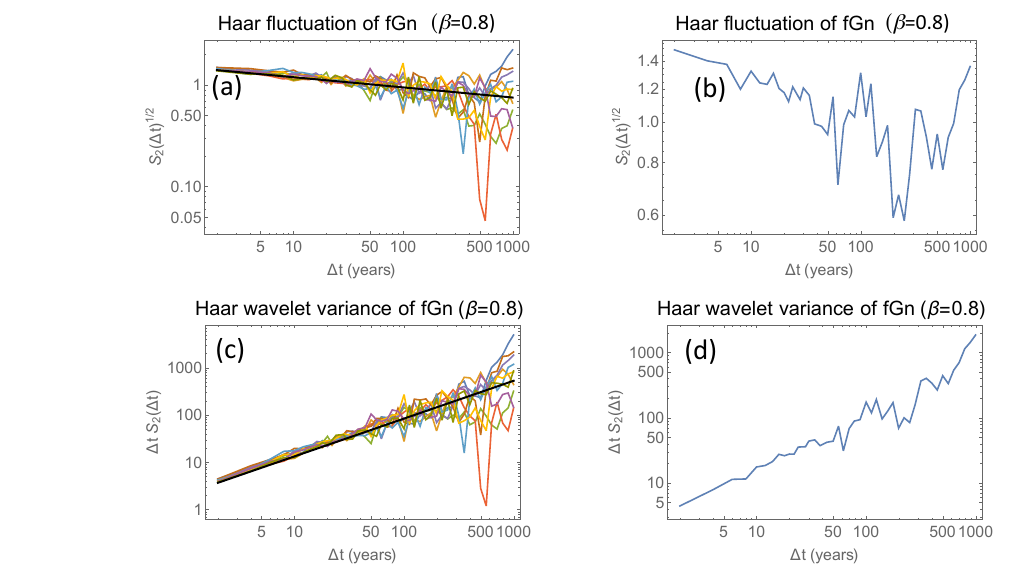
Figure 3. (a) The Haar fluctuation of 20 realizations of an fGn with β = 0.8. (b) The Haar fluctuation of one realization in the ensemble. (c) The Haar wavelet variance of the same 20 realizations as in (a) . (d) The Haar wavelet variance of the same realization as in (b) .